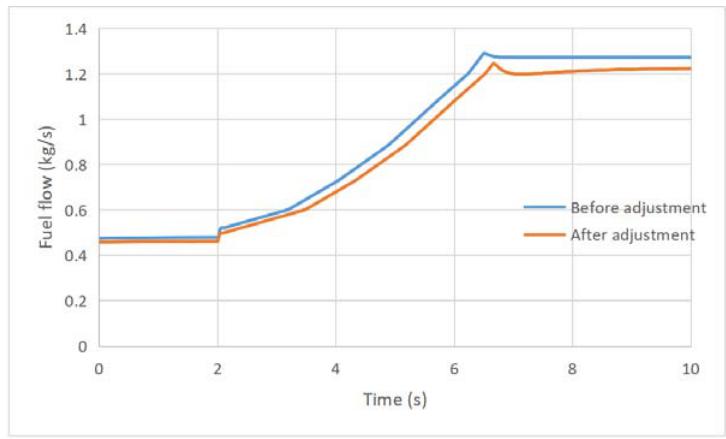
Figure 27. Comparison of the fuel flow to the degraded engine before and after adjustment of the controller.